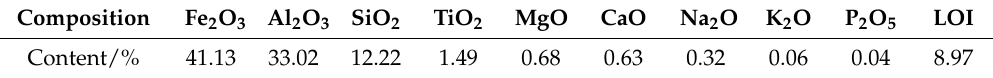
Table 2. Proximate analysis of the coal used.